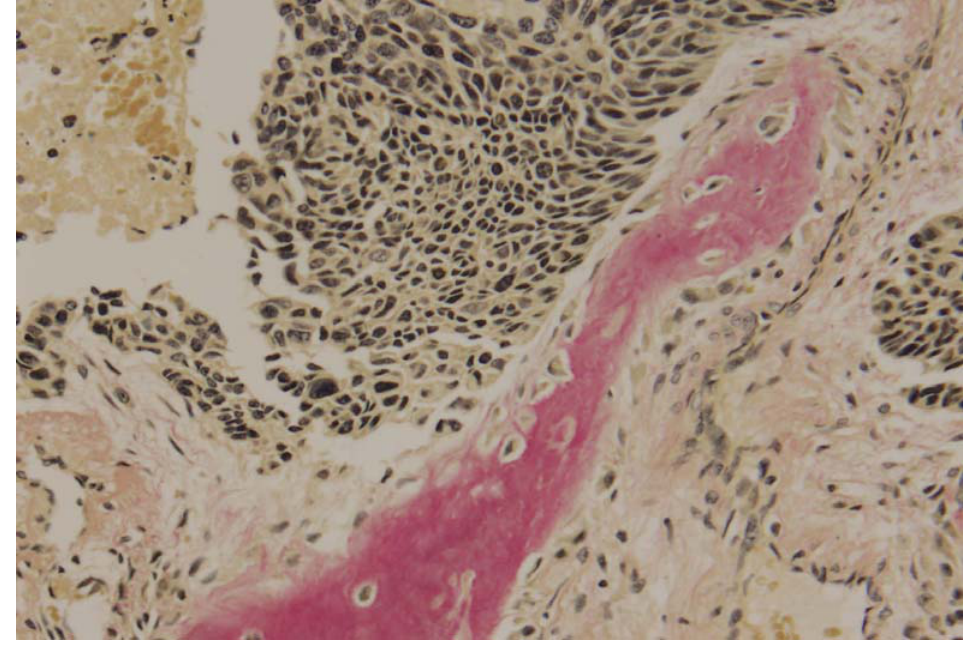
FIGURE 4. Central fragment of newly formed bone (pink) immediately surrounded by a layer of osteoblasts and with sheets of TCC replacing the marrow.